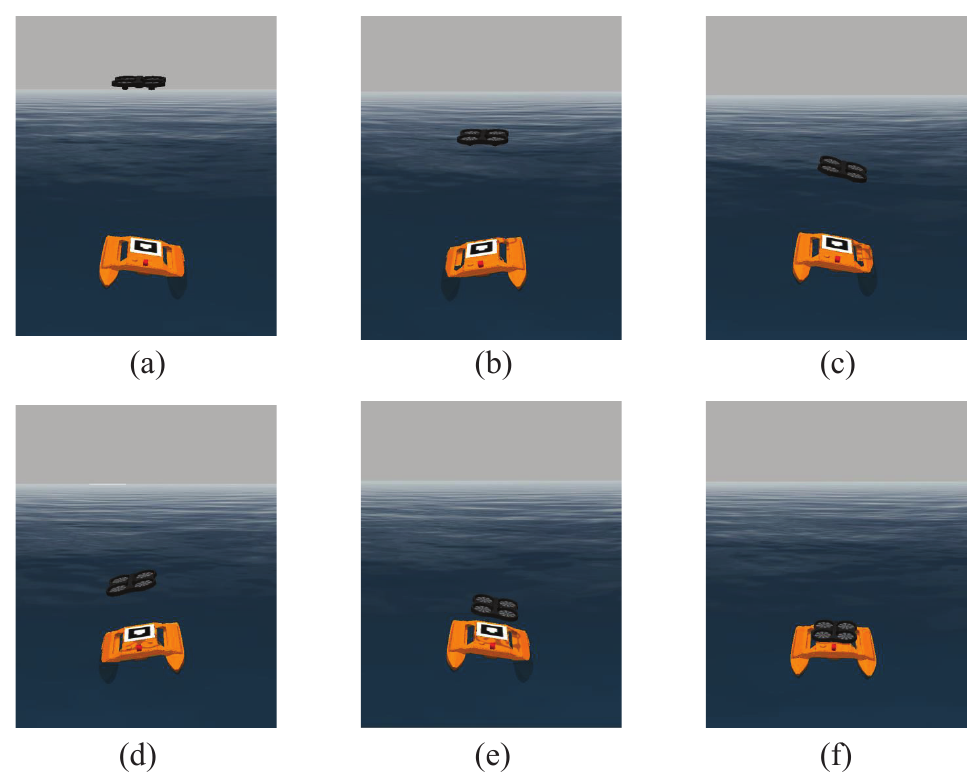
Figure 15. UAV landing autonomously on USV, affected by USV roll motion only. The UAV altitude does not reach the altitude threshold h 1 (set to 2 m), the UAV continues to descend in altitude ( a , b ); the UAV altitude is less than the altitude threshold h 1, the UAV and the USV attitude remain synchronized ( c , d ); the UAV altitude is less than the altitude threshold h 2 (set to 0.2 m), the UAV accelerates to land on the USV ( e ); the UAV completes landing on the USV operation ( f